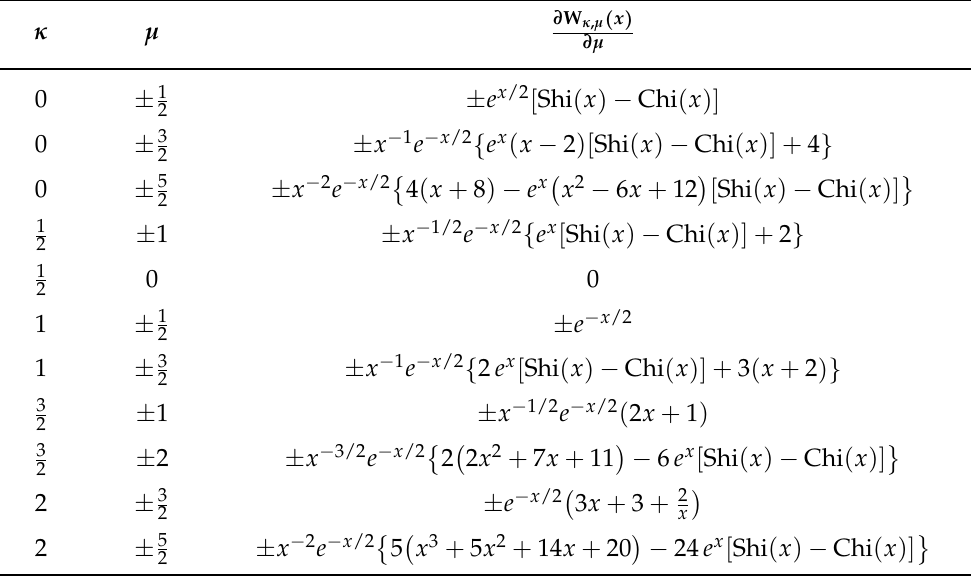
Table 8. Derivative of W κ , µ with respect to µ , by using (109) and